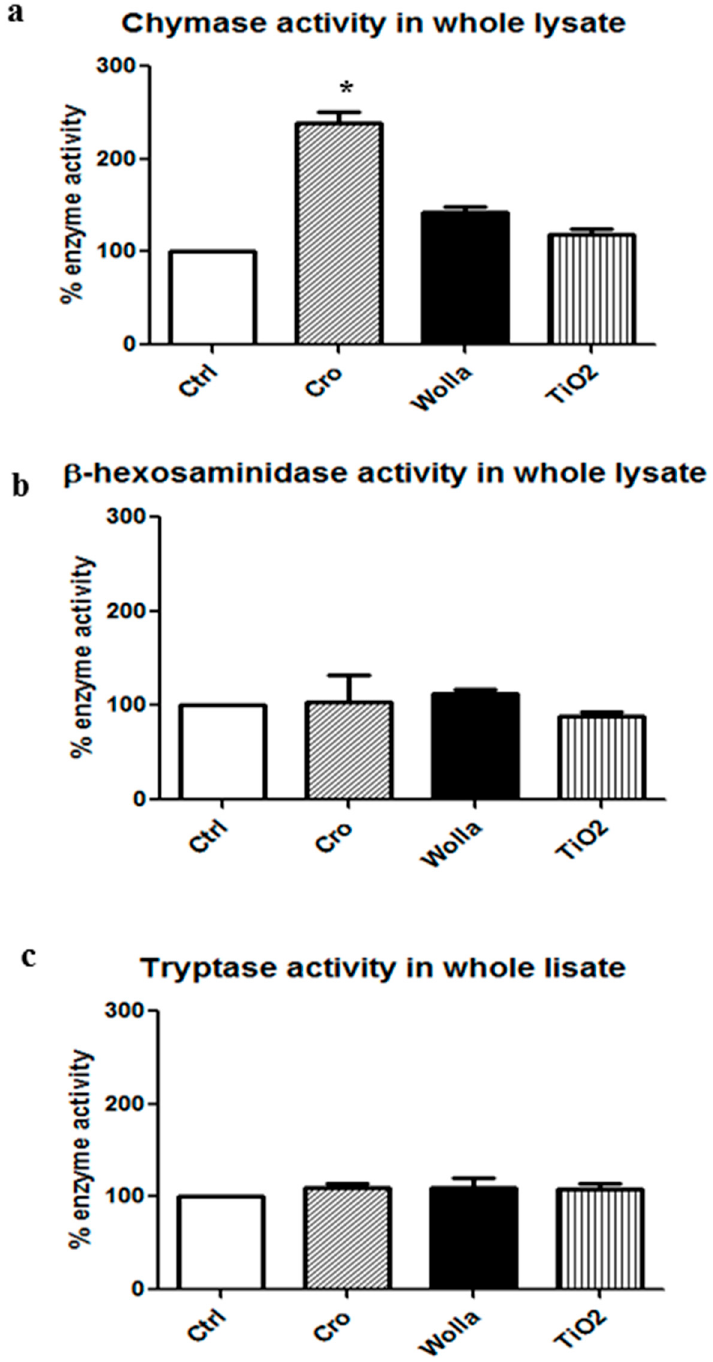
Figure 7. Effects of mineral fibers on enzyme activities in RPMC lysate. RPMC total lysate was obtained by sonication (3 × 10 6 RPMC in 1 mL) and incubated for 30 min with mineral fibers (100 μ g/mL). The values reported are the mean ± SD of at least five different experiments. The extent of enzyme activity was calculated taking the total enzyme activity present in the whole lysate as 100% (0.390 ± 0.052 OD/30 min for chymase; 0.160 ± 0.080 OD/30 min for β -hexosaminidase; 0120 ± 0.05 OD/30 min for tryptase (TRY)). Significant differences ( p < 0.05) between unstimulated lysate and lysate from RPMC exposed to mineral fibers are indicated by asterisks. CTRL = unstimulated cells; Cro = crocidolite stimulated cells; Wolla = wollastonite-stimulated cells; TiO 2 = TiO 2 NW-stimulated cells; 48/80 = 48/80-stimulated cells.